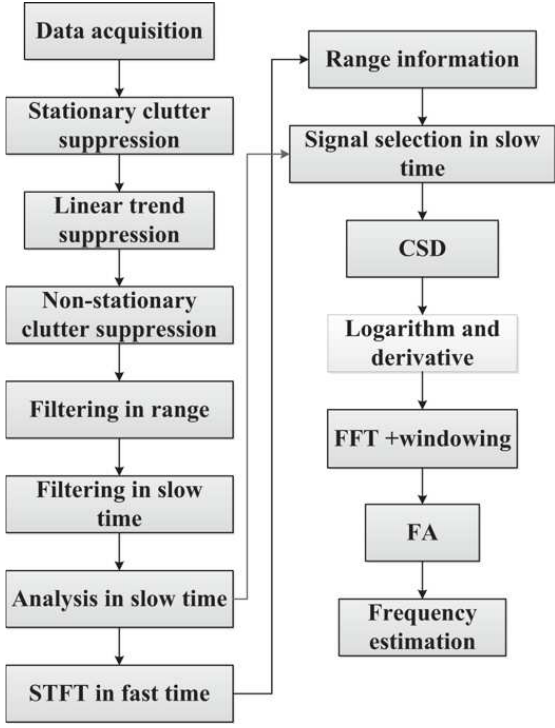
Figure 20. Detection algorithm